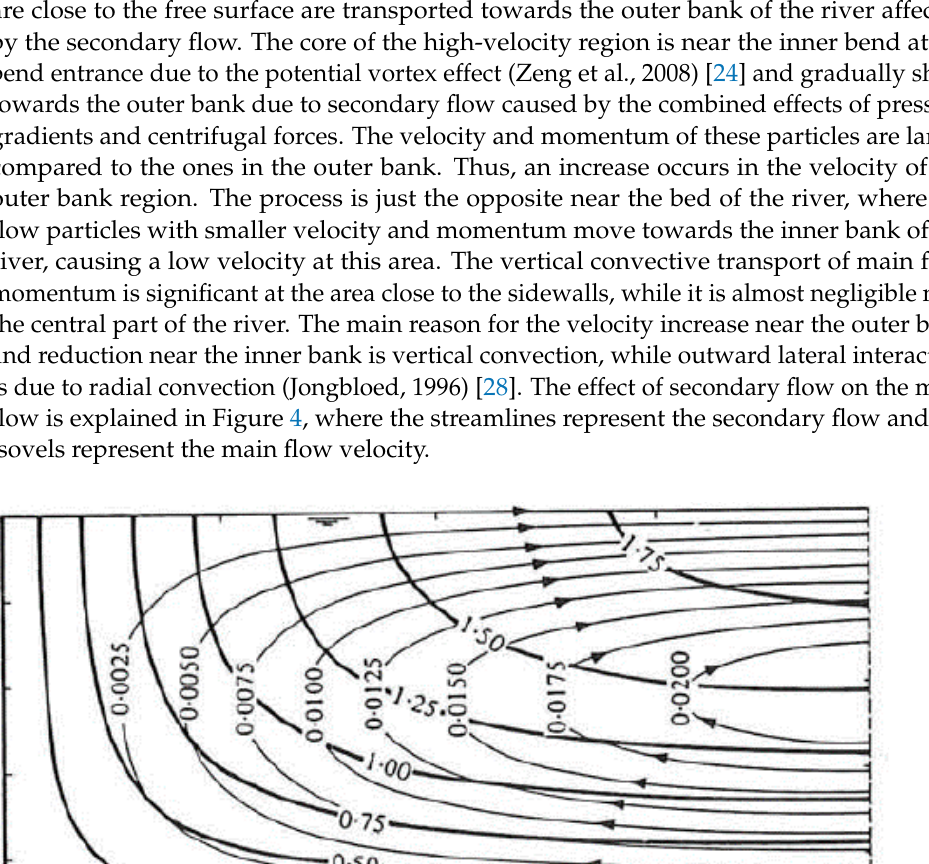
Figure 3 . Secondary flow cells (based on Blanckaert (2011) [31] .